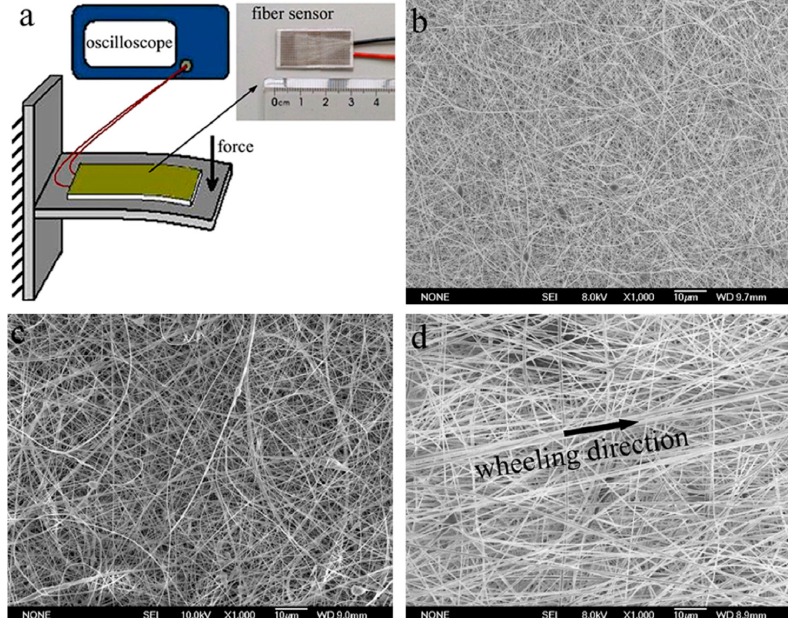
Figure 15. ( a ) Schematic illustration of the piezoelectric response experimental setup and the inset is photograph of the assembled full-fibre sensor; SEM images of ( b ) PVDF nanofibers, ( c ) PVDF / nanoclay nanofibers, and ( d ) PVDF / nanoclay nanofibers by NWS method [26].